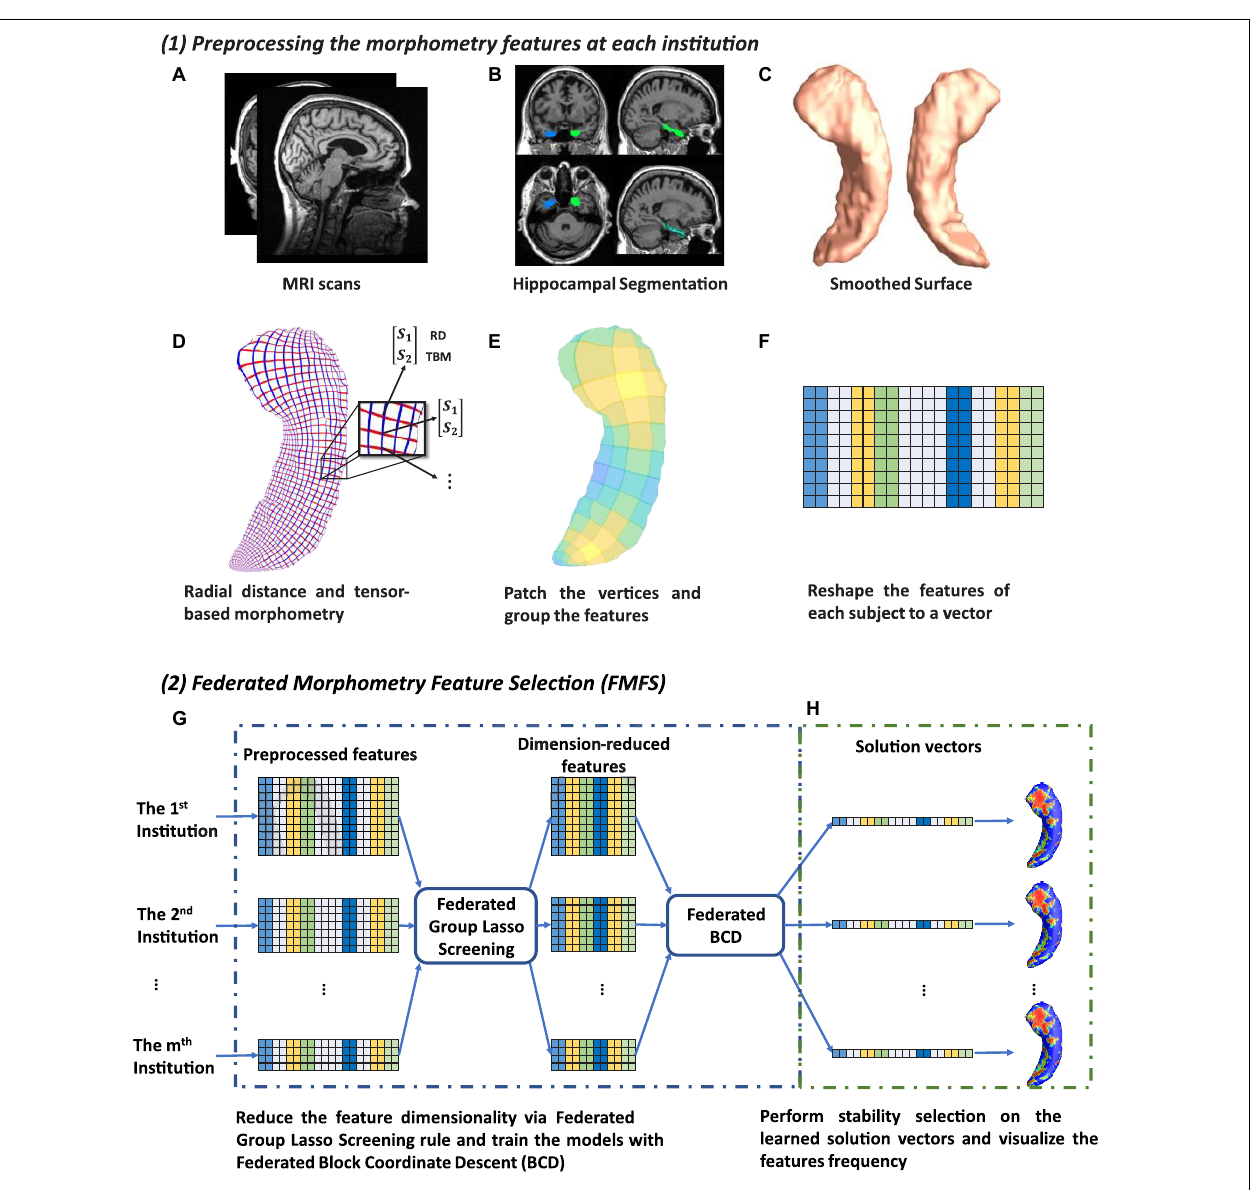
FIGURE 1 | System pipeline. Panel (1) shows the steps for each institution to extract morphometric features locally. The hippocampal structures are segmented from registered brain MR images and smoothed hippocampal surfaces are then generated (A–C) . After the surface parameterization and fluid registration, the hippocampal radial distance (RD) and tensor-based morphometry (TBM) features are calculated at each surface point (D) . Each institution selects patches on each hippocampal surface and reshapes the grouped features of each subject into a vector (E,F) . Next, in panel (2) (G,H) , taking A β /tau measurements as dependent variables, the institutions perform the federated feature selection model on these patches of features to generate hippocampal local regions of interest (ROIs) for each A β /tau measurement.